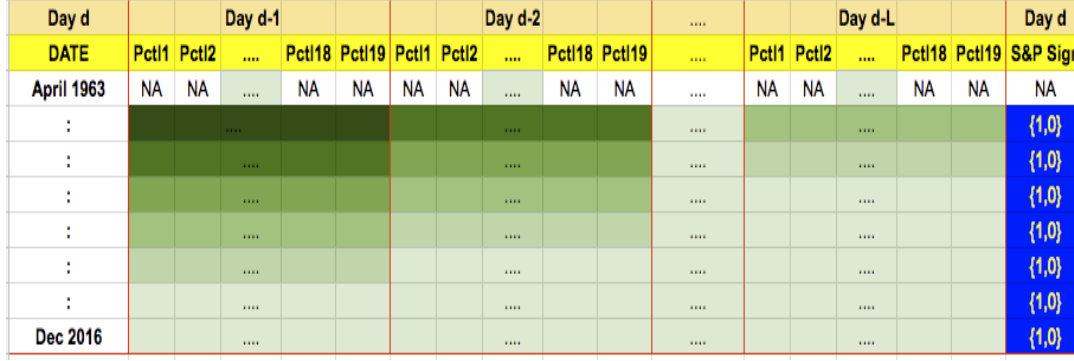
Figure 4. Data for prediction analysis after rearrangement. The label is the sign of the S&P movement, shown in the last column. The feature set comprises L sets of C = 19 percentiles for L lagged